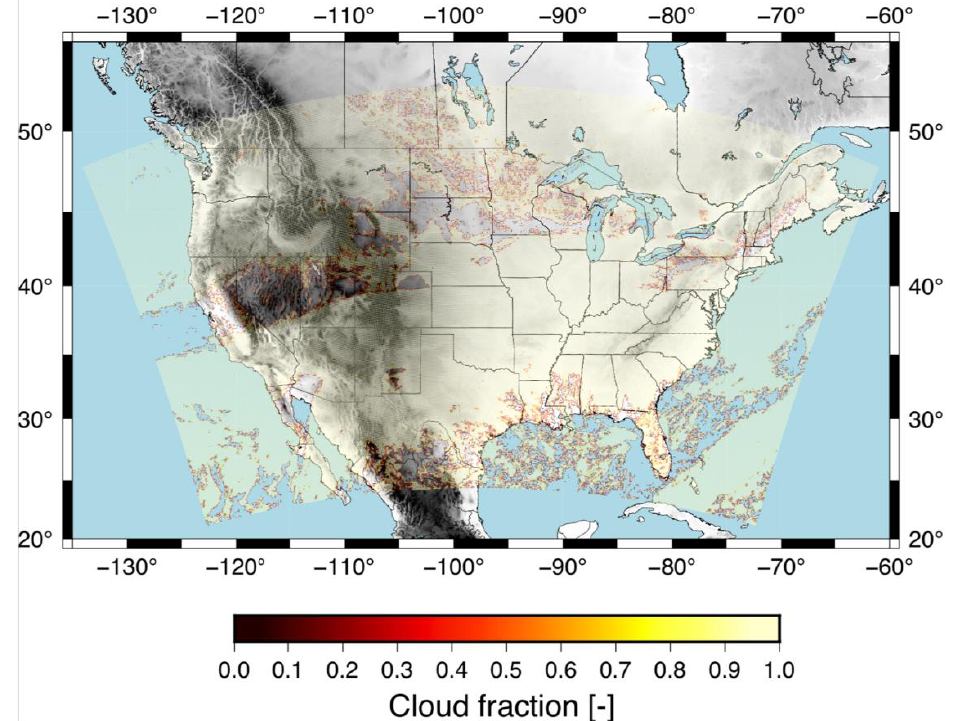
Figure 9. GOES algorithm cloud mask product for 1 April 2018 at 19Z.